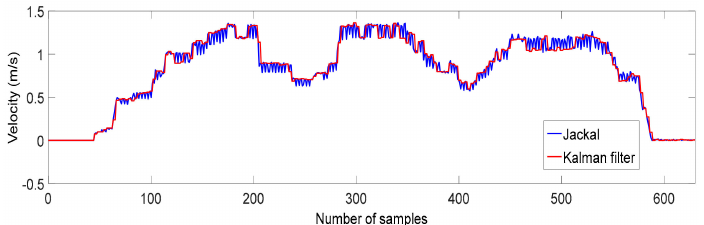
Figure 3. Comparison between the estimated and real